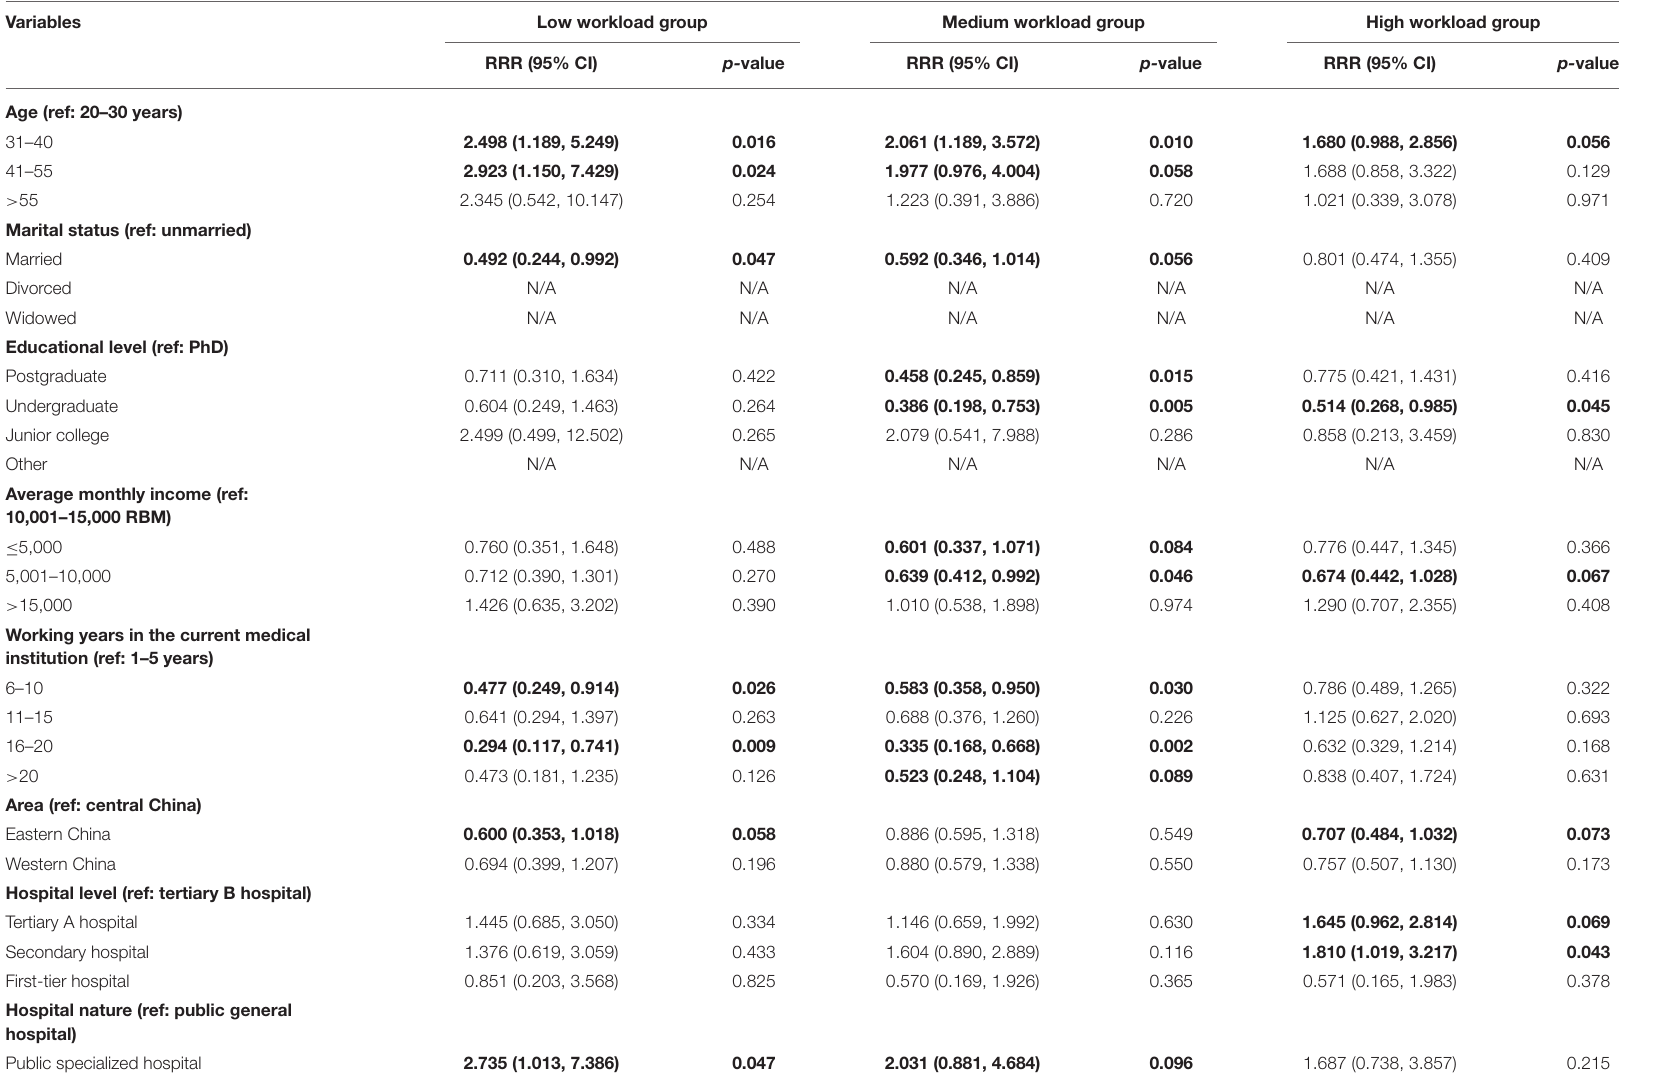
TABLE 4 | Multinomial logistic regression results: significant determinants of latent subgroups of physician workload tethered to non-physician-patient communication work tasks characterized by paperwork during outpatient encounters (base outcome = “very high workload group”).